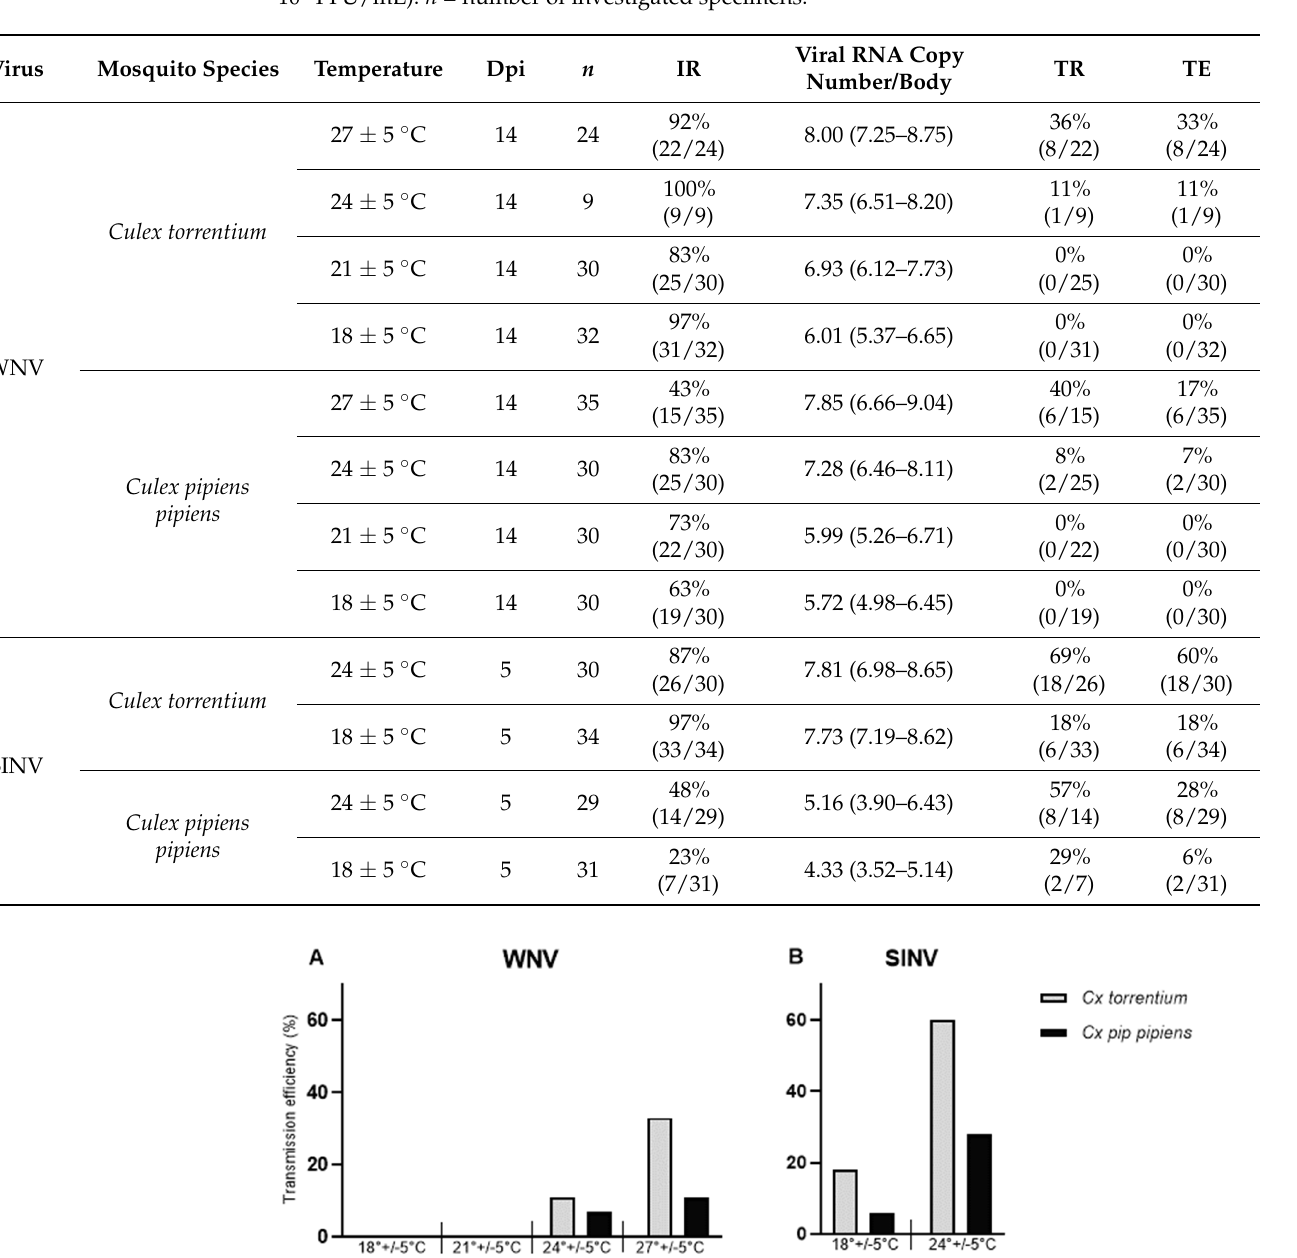
Figure 1. Transmission efficiency (TE) of Culex torrentium and Culex pipiens biotype pipiens at 70% hu- midity and different temperature profiles for ( A ) West Nile virus (WNV, 14 dpi) at an MOI of 10 7 PFU/mL) and ( B ) Sindbis virus (SINV, 5 days post-infection (dpi).